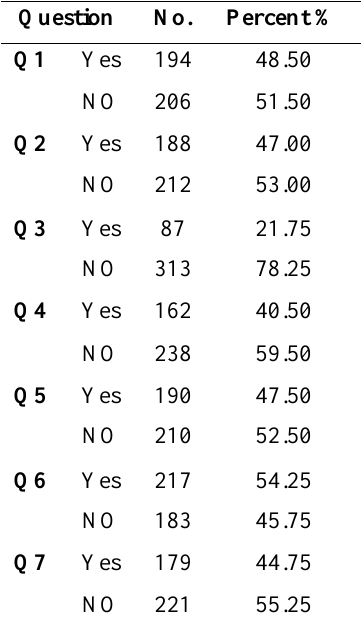
Table (1): Distribution of students by